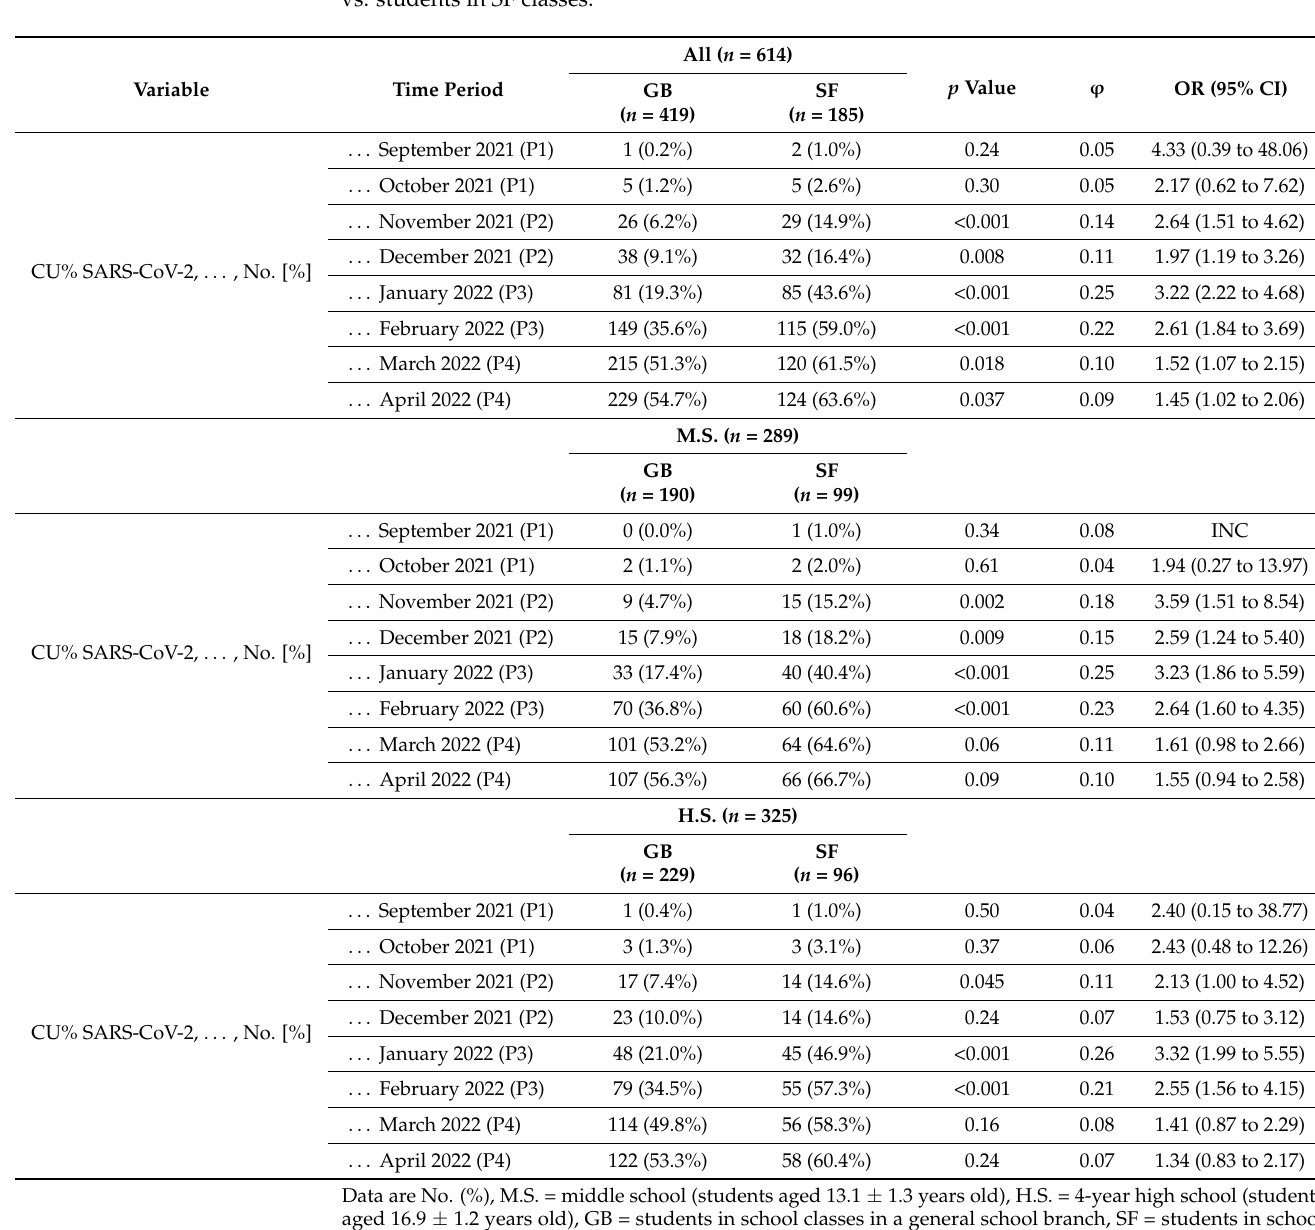
Table 1. Cumulative percentage of students with a SARS-CoV-2 infection: students in classes in GB vs. students in SF